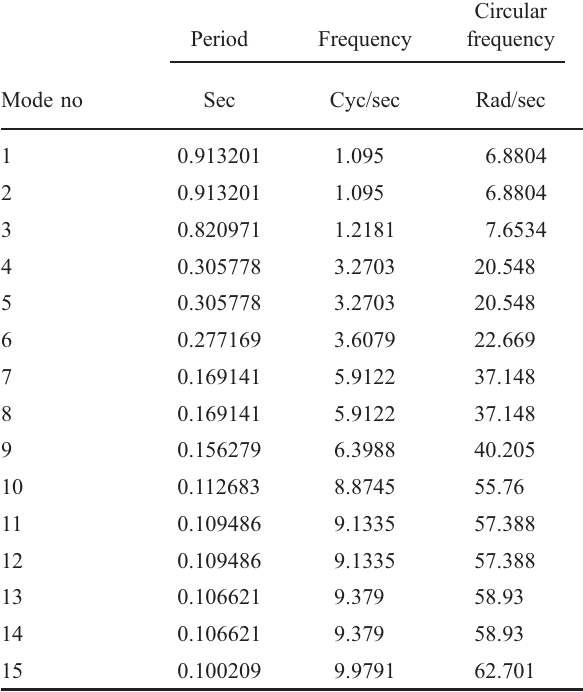
Table 3. Free vibration analysis result (fixed